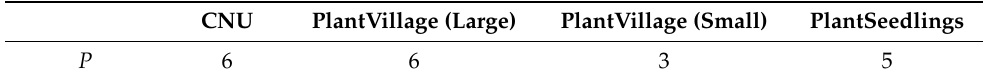
Table 3. Number of training periods, P .